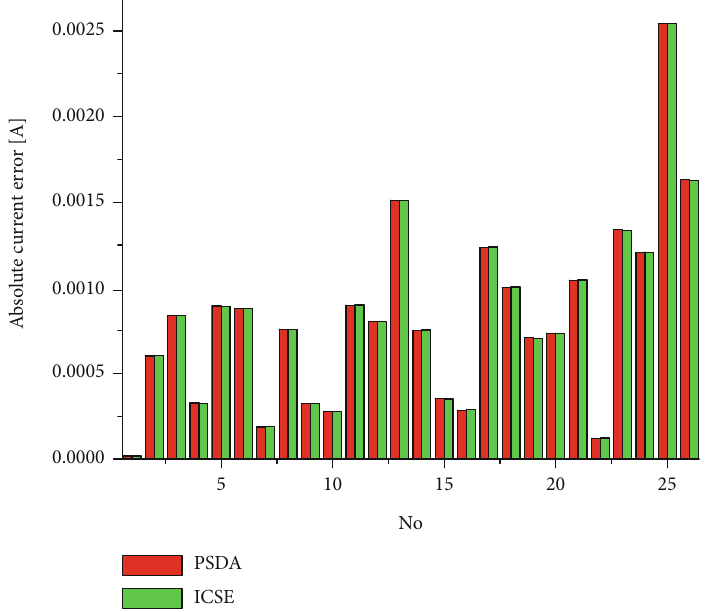
Figure 4: Absolute current error comparison for